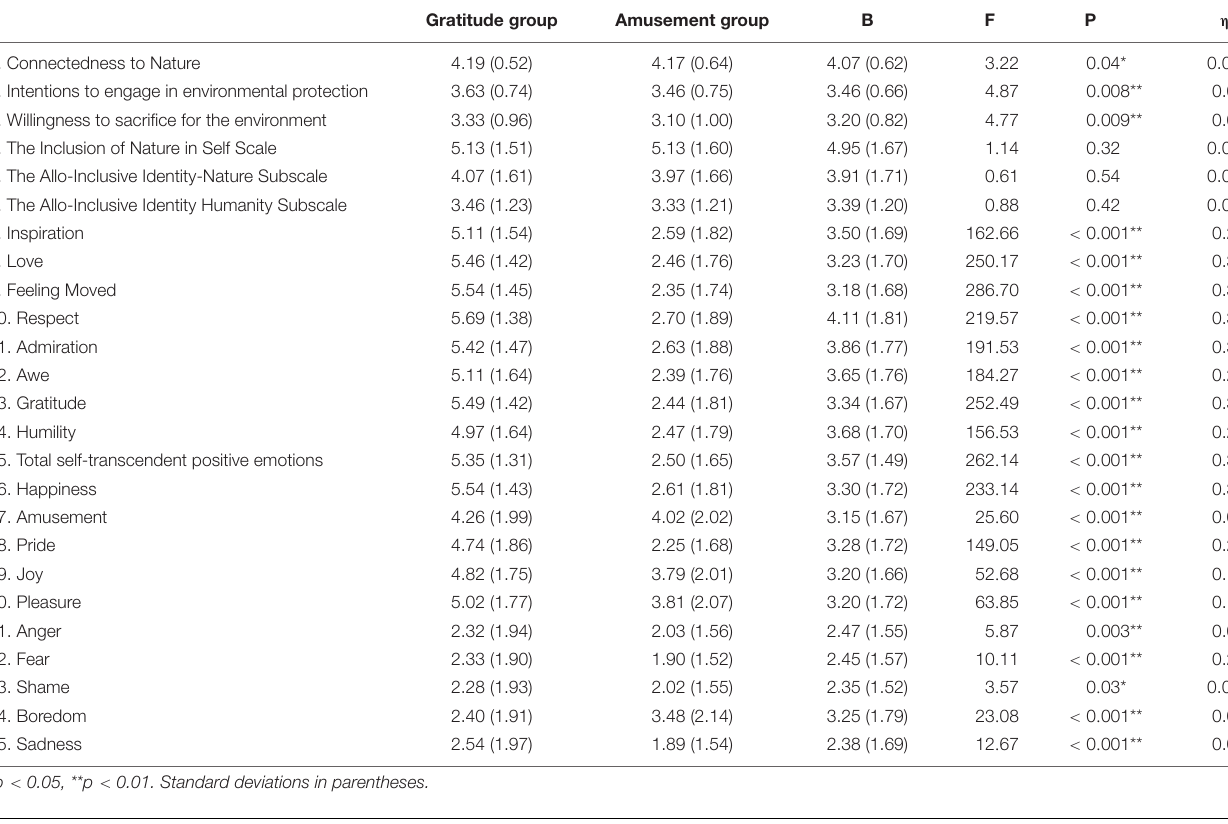
TABLE 2 | Effects of condition on mean score of outcomes.